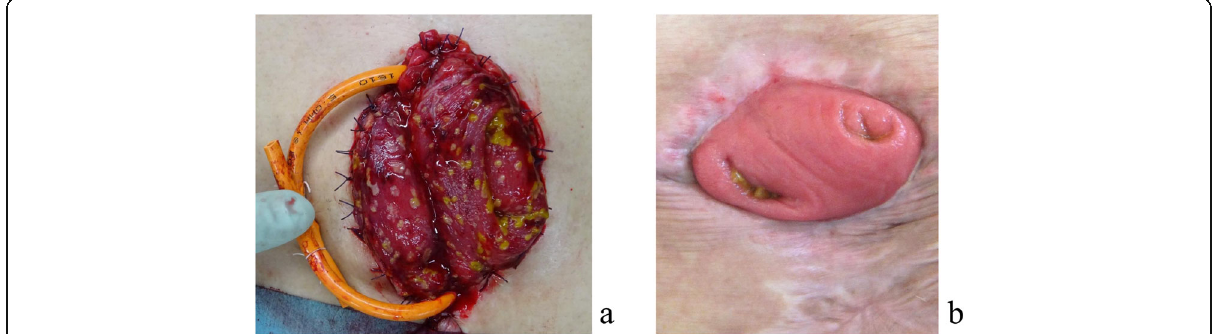
Fig. 8 The pseudomembranous change of the transverse colostomy observed just after creation of the stoma (Fig. 8a) disappeared after intensive therapy (Fig.